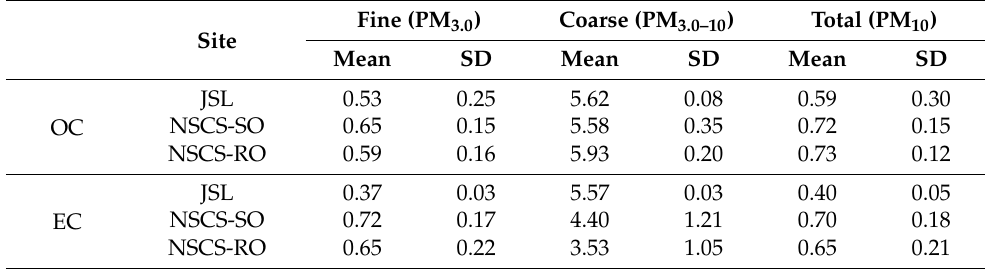
Table 2. MMDs ( µ m) of the whole range of impactor particle sizes (total), fine and coarse particles. Fine (PM 3.0 Site